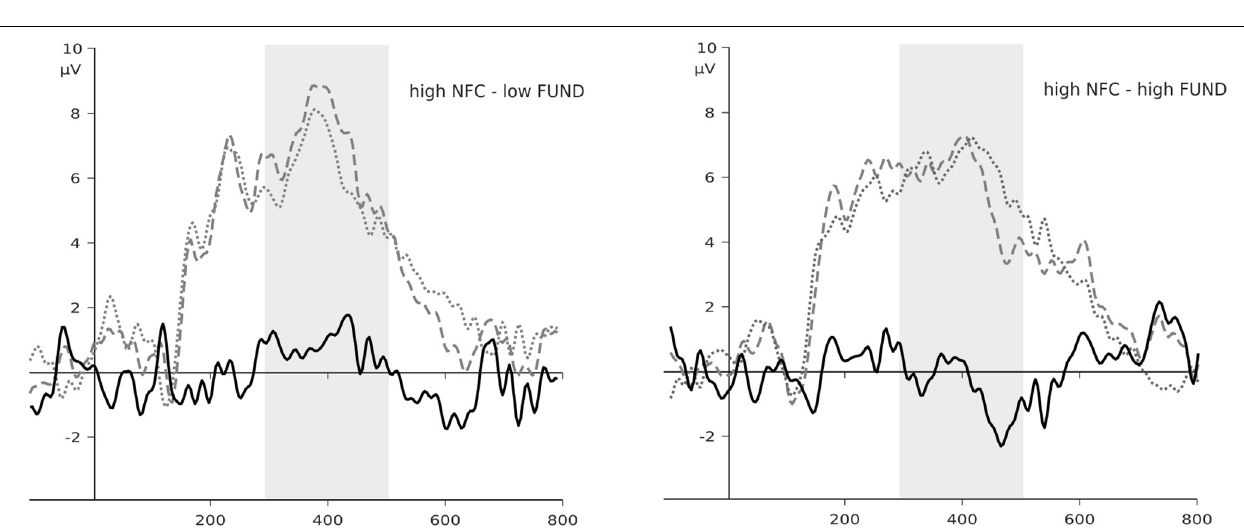
FIGURE 1 | Interaction between need for closure (NFC) and Fundamentalism on Stroop effect index (N400 for error words – N400 for neutral words). The more negative score, the stronger interference. For religious fundamentalism –1 SD, +1 SD values were used.